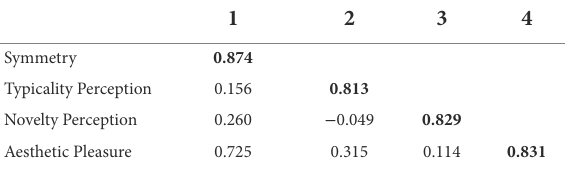
TABLE 2 Variables correlations and square roots of